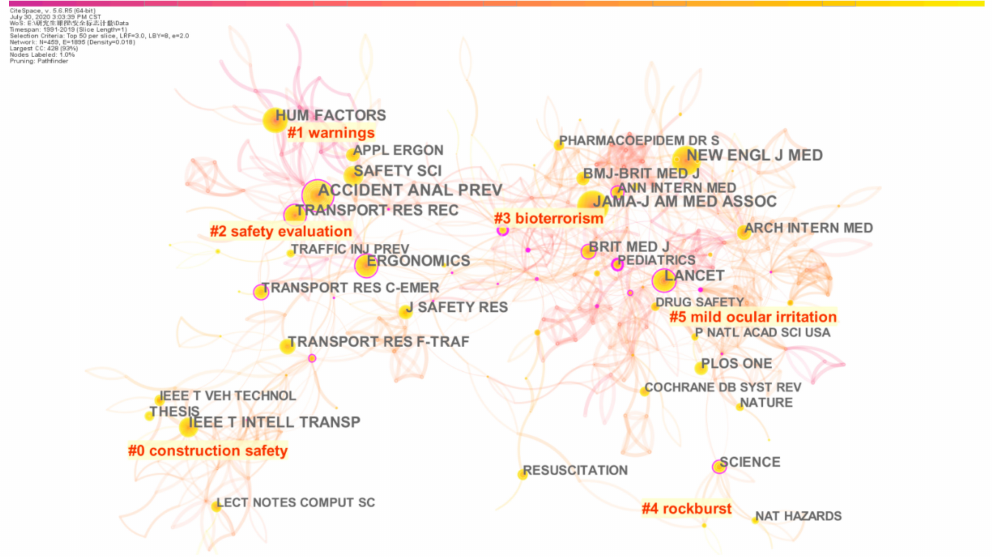
Figure 5. Journals co-citation clustering network of safety signs research. Note: Clusters are referred to in terms of the labels selected by the log-likelihood ratio test method